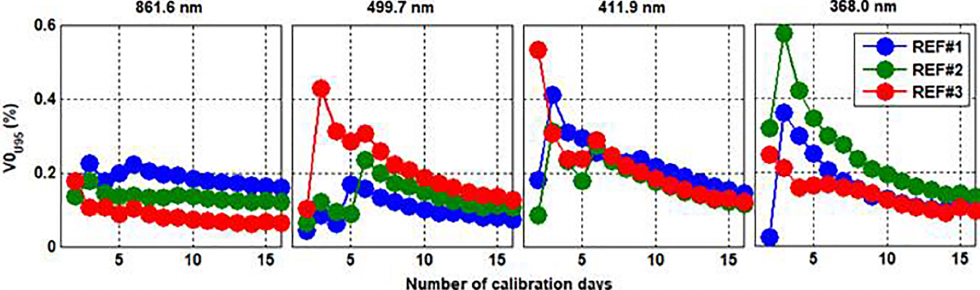
Figure 6. Graphs of V 0 calculated over an extended calibration period of 35 days for a PFR instrument measuring against each of the U95 three triad instruments for the four PFR